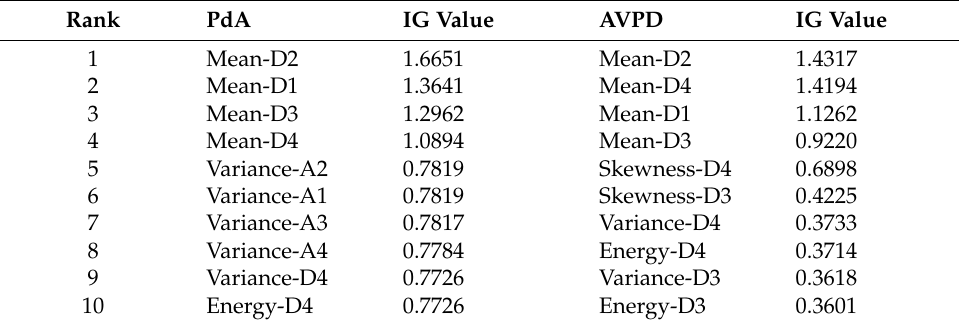
Table 13. Top 10 ranked descriptors for multiclass.